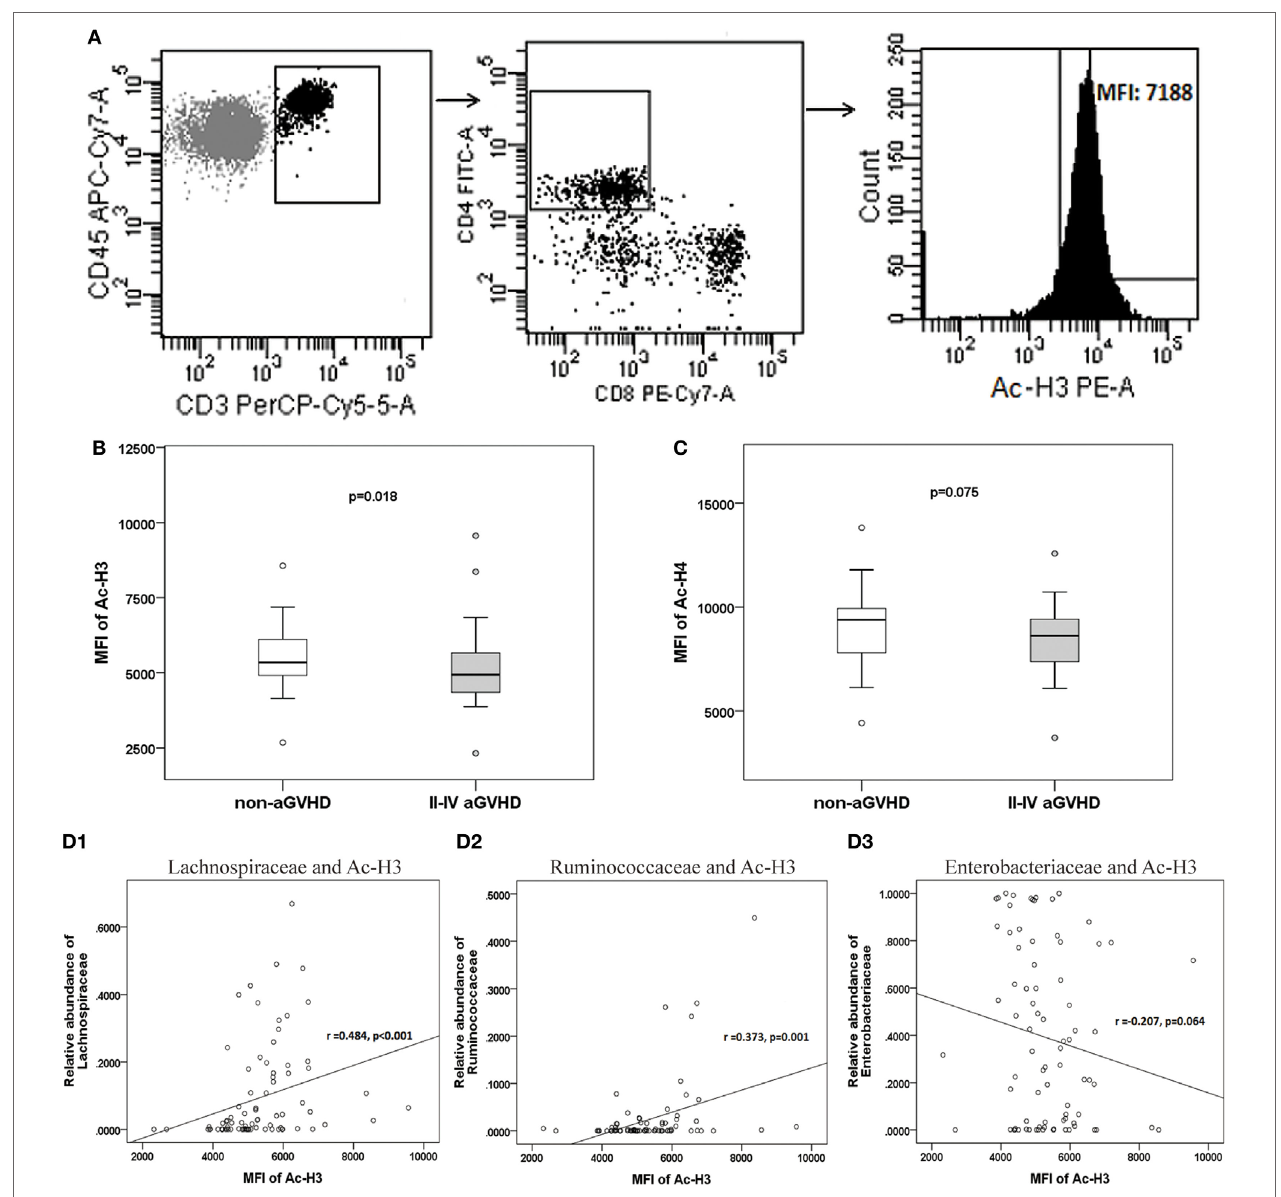
FigUre 7 | The level of acetylated histone is associated with acute graft-versus-host disease (aGVHD), and correlates with microbiota. (a) Peripheral mononuclear blood cells were examined by flow cytometry, after gating with CD45 + and CD3 + , CD4 + and CD8 − . The median fluorescence intensity (MFI) of the acetylated histones is shown in the histogram. (B) The MFIs for acetylated histone H3 (Ac-H3) and (c) Ac-H4 were compared between the aGVHD and non-aGVHD groups. The correlations between the relative abundance of the Lachnospiraceae (D1) , Ruminococcaceae (D2) , or Enterobacteriaceae families (D3) , and